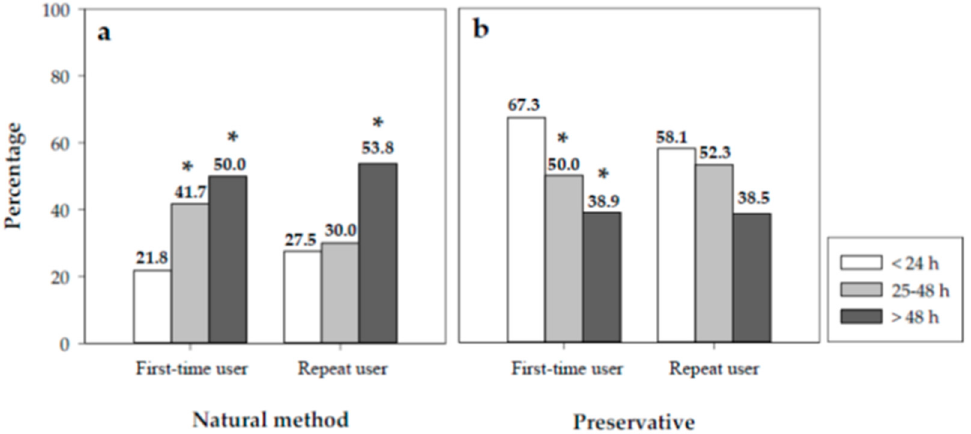
Figure 3. Percentages of first-time users and repeat users according to the time of collection of the medica-tion and their contraceptive behavior: ( a ) natural method, ( b ) preservative. Significant differ-ences: * vs. < 24 h ( p < 0.05).